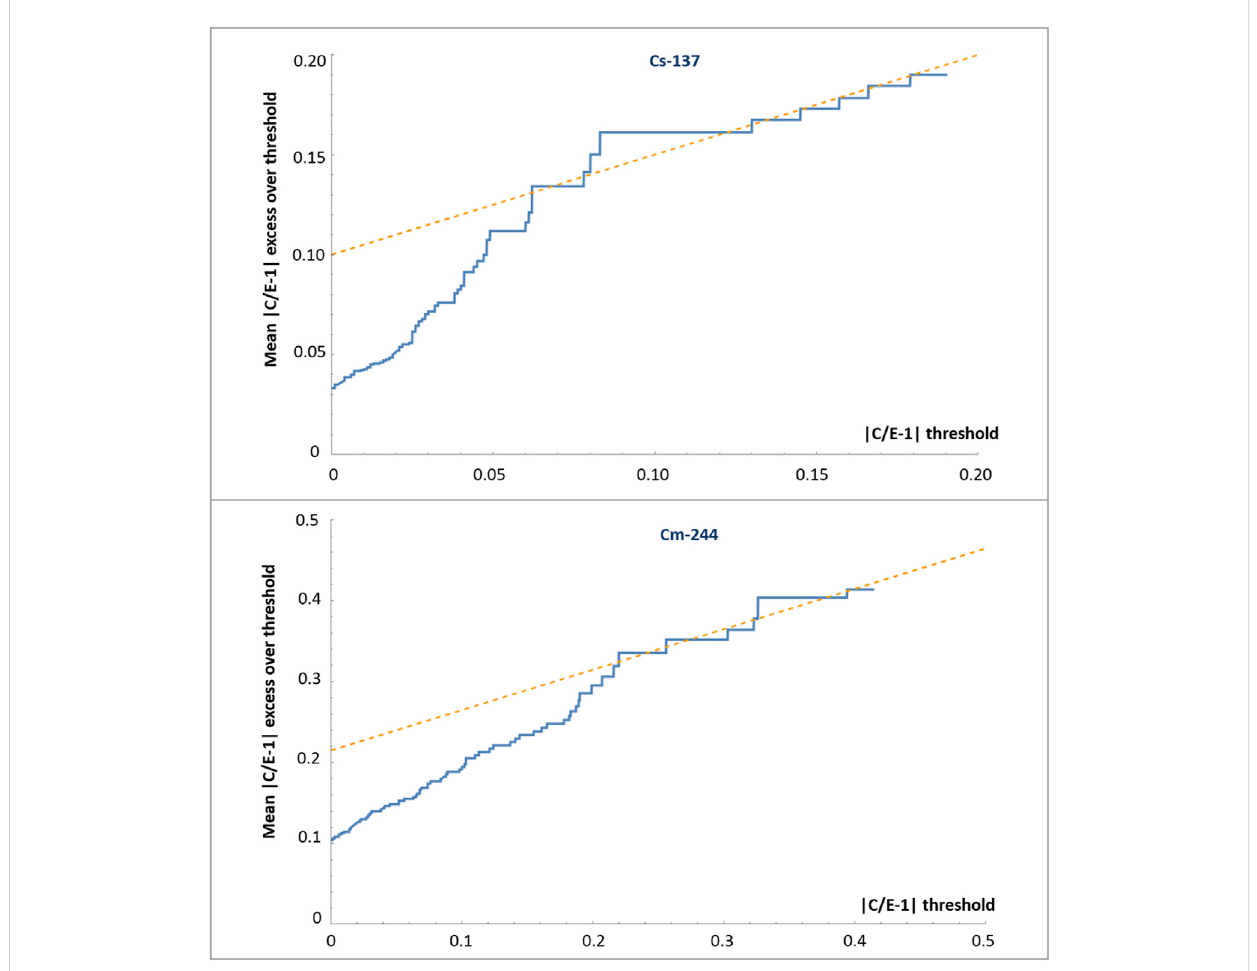
FIGURE 9 Distributionofexcesses M ( u ) (inblue)for 244 Cmand 137 Csand fi tofasymptoticexcess(inorange).Thehorizontalaxisshowsthethresholdappliedto C/E-1 and the vertical axis is the mean of excesses above this